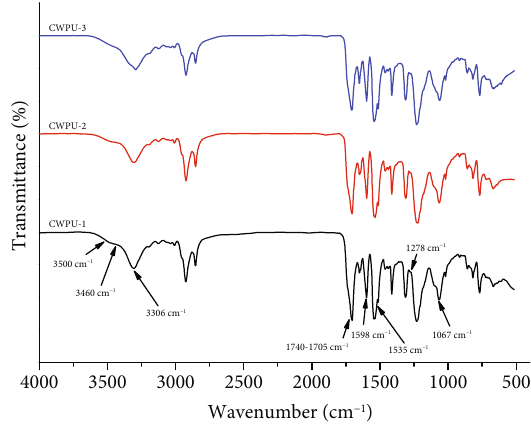
Figure 3: FT-IR spectra of cationic waterborne polyurethanes (CWPUs) with various internal emulsi fi er